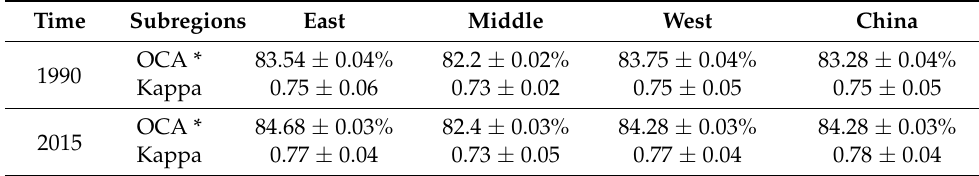
Table 1. Accuracy of land-cover type classification of major cities in China.